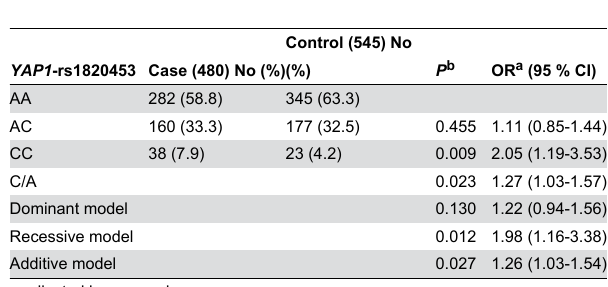
Table 2. The association between rs1820453 and BC risk in Chinese